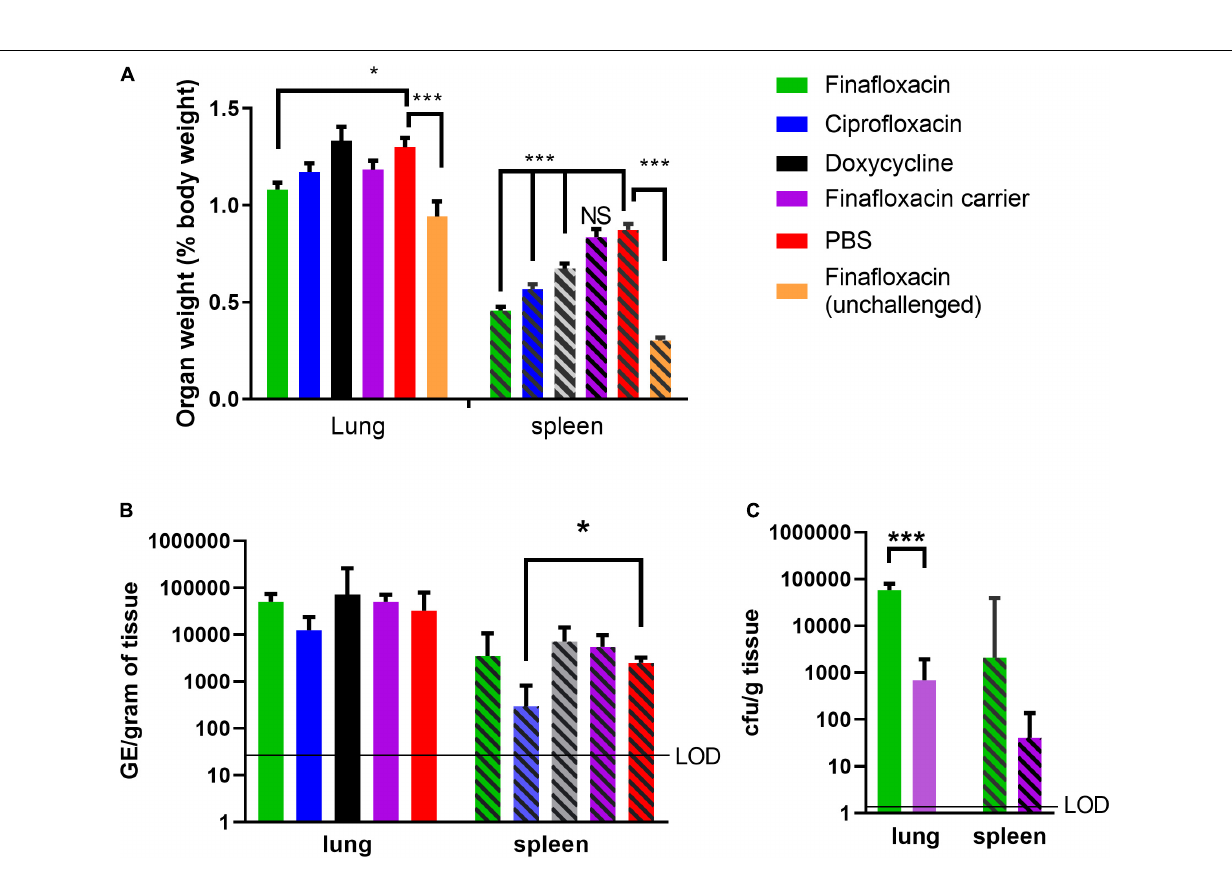
Frontiers in Microbiology |